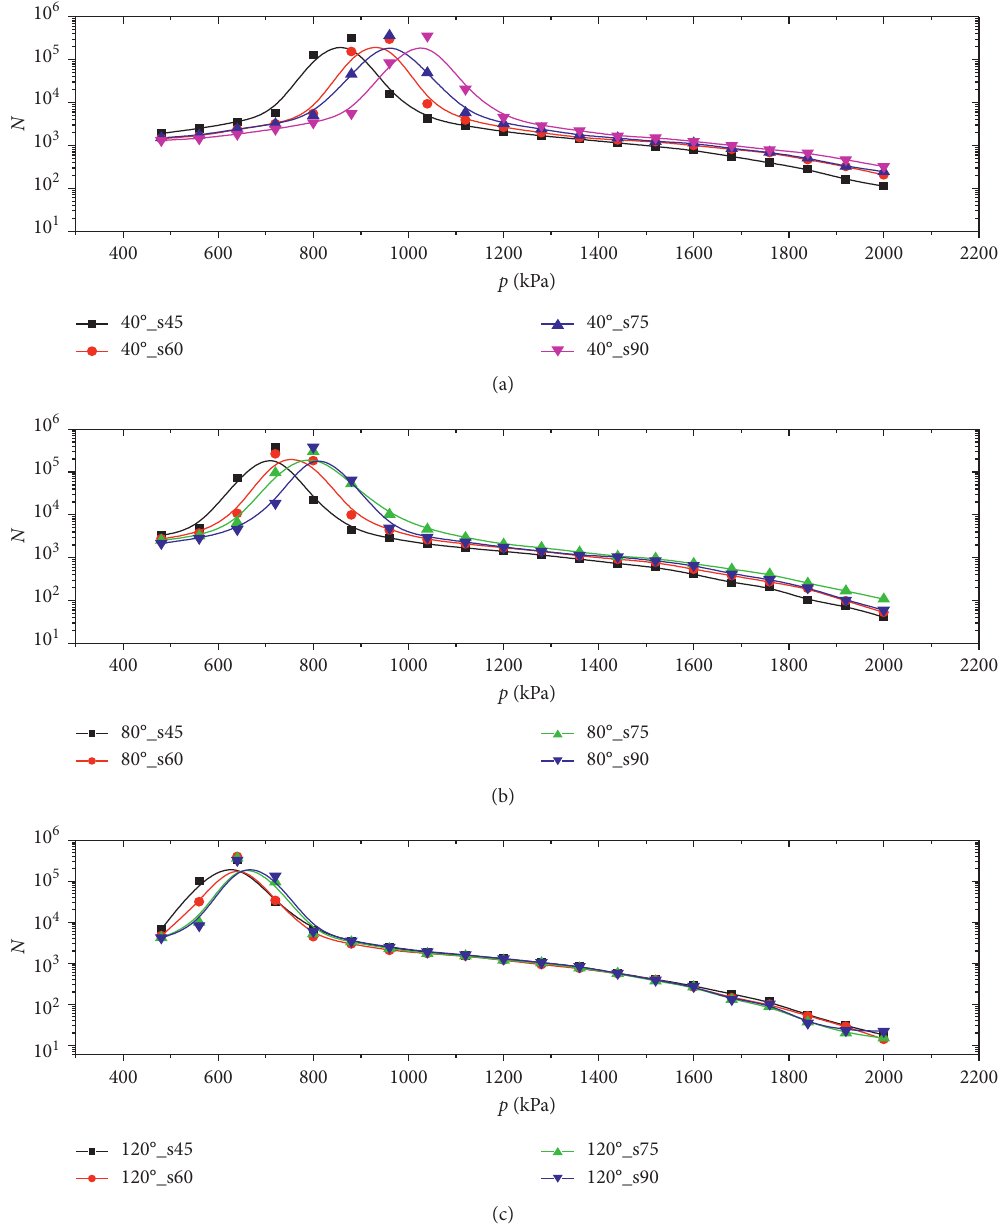
Figure 13: Number density versus peak height with different stand-off distances ( σ � 0 .